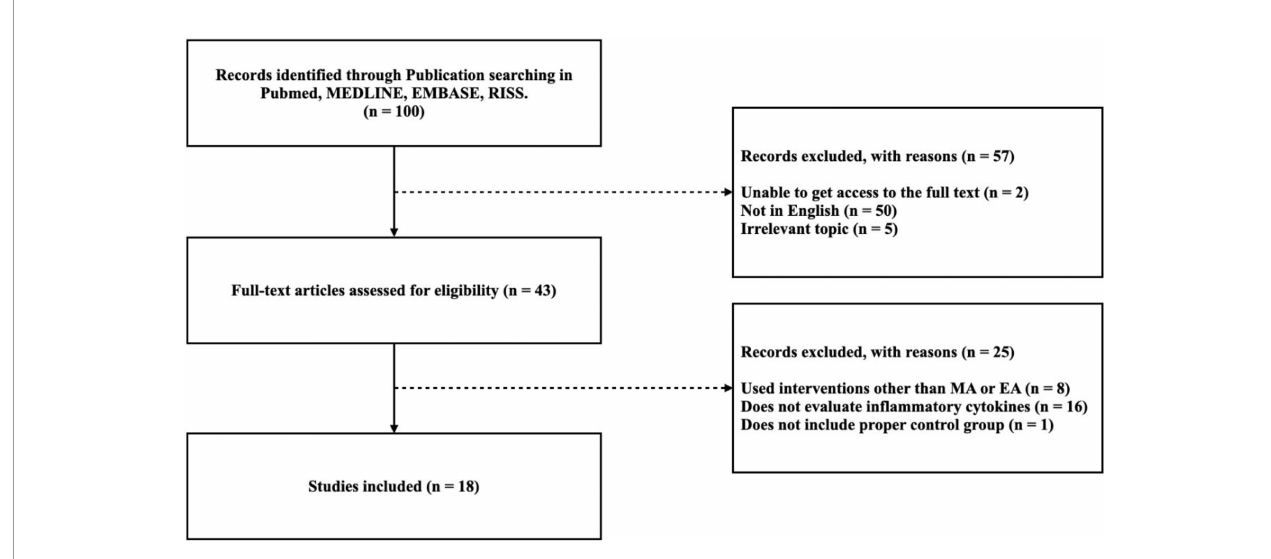
FIGURE 1 | Flowchart of the